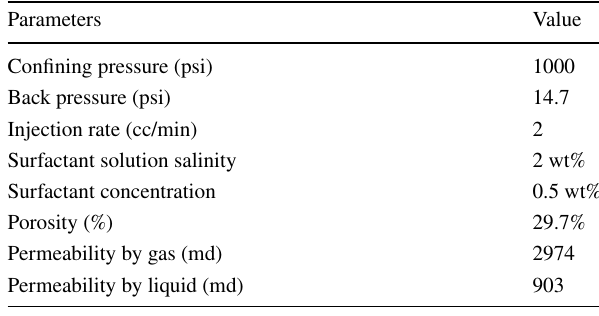
Table 7 Operating conditions of corefloods